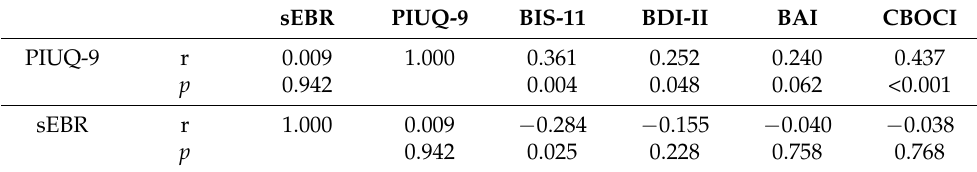
Table 2. Association of the PIU level and sEBR with selected tests of psychological